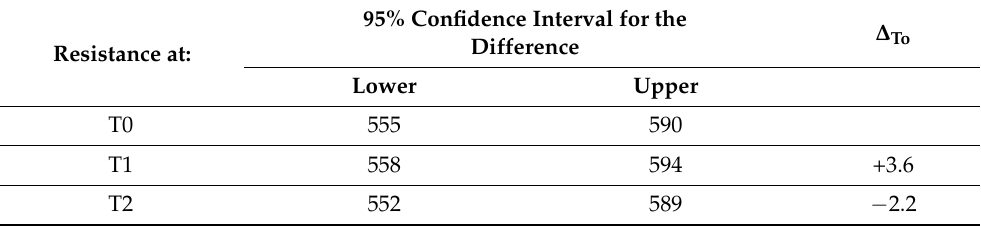
Table 5. Acupuncture—lower and upper values of resistance ( Ω ). The deltas of the average resistance values ( ∆ To ) are Table 5. Acupuncture— lower and upper values of resistance (Ω). The deltas of the average resistance values ( Δ To ) are included.